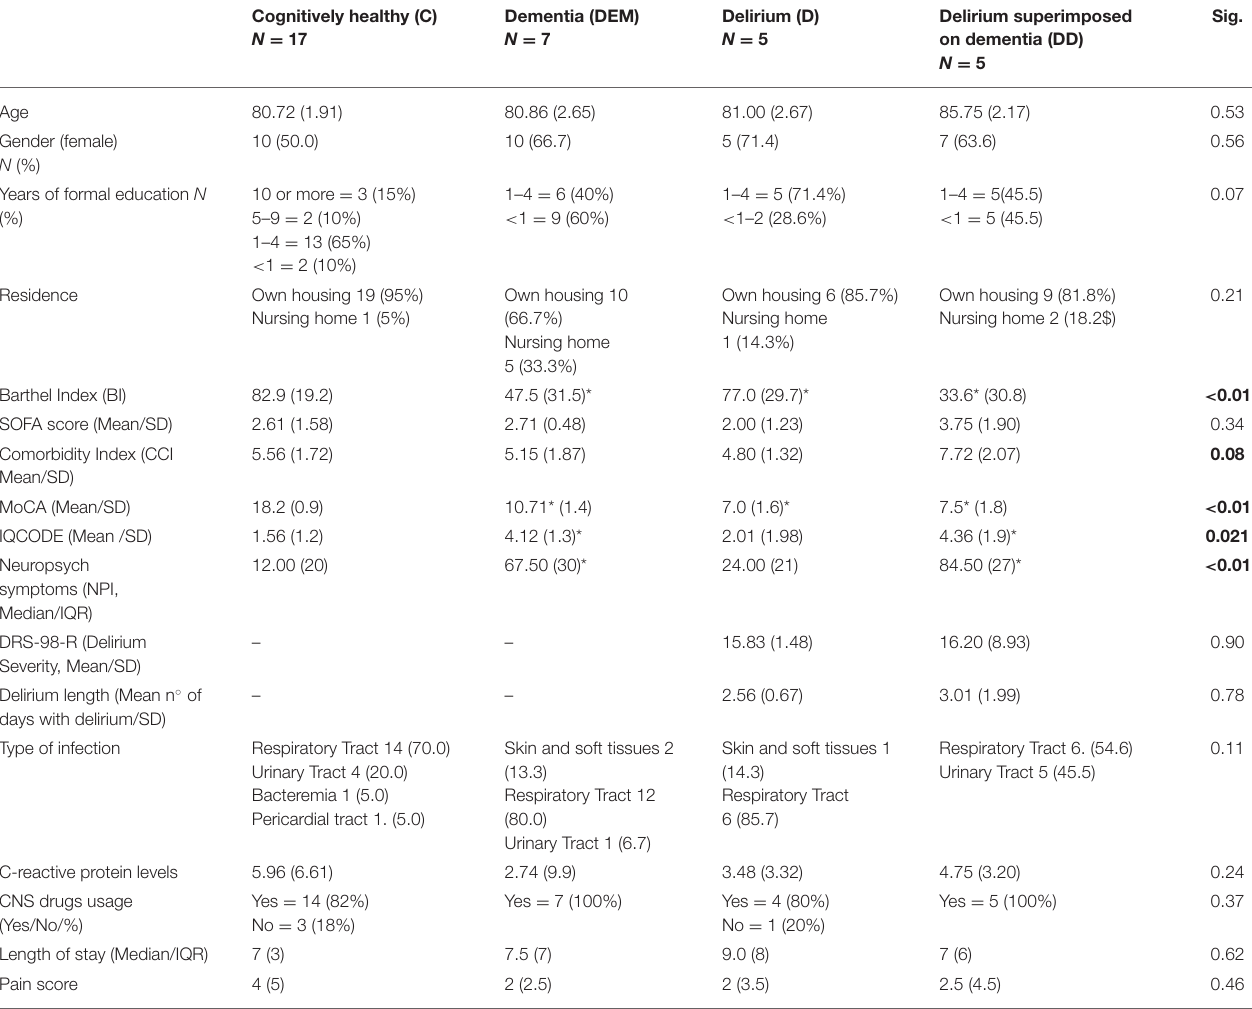
TABLE 1 | Baseline clinical features of the participants who completed the study ( N = 34).